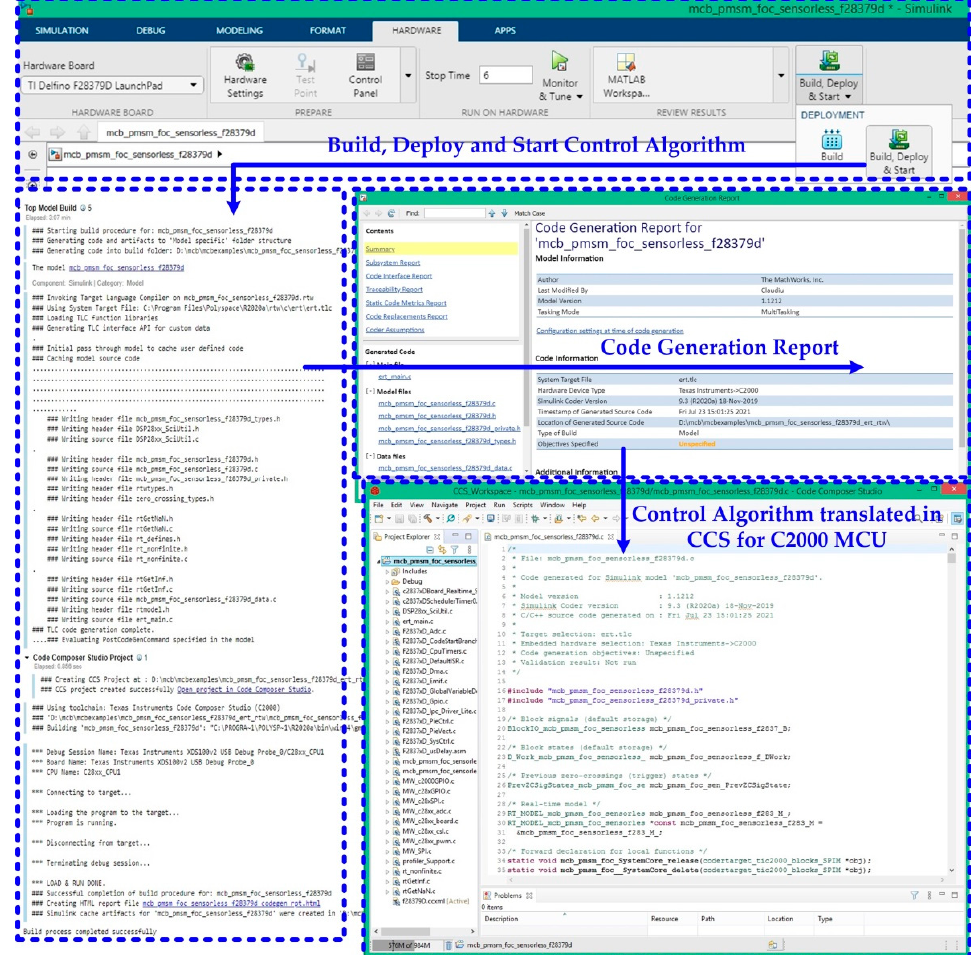
Figure 33. Build, deploy, and start of the PMSM control algorithm in TMS320F28379D MCU.